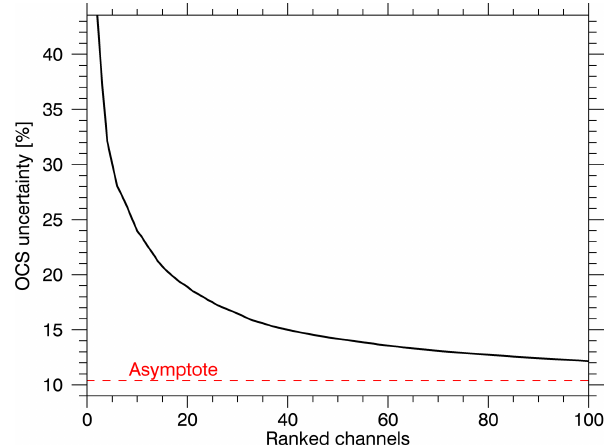
Figure 7. Ranked spectral channels are shown for a mid-latitude at- mosphere based on their contribution towards minimizing the pos- terior uncertainty of OCS. The asymptote from including all 1201 channels is shown as the dotted red line.